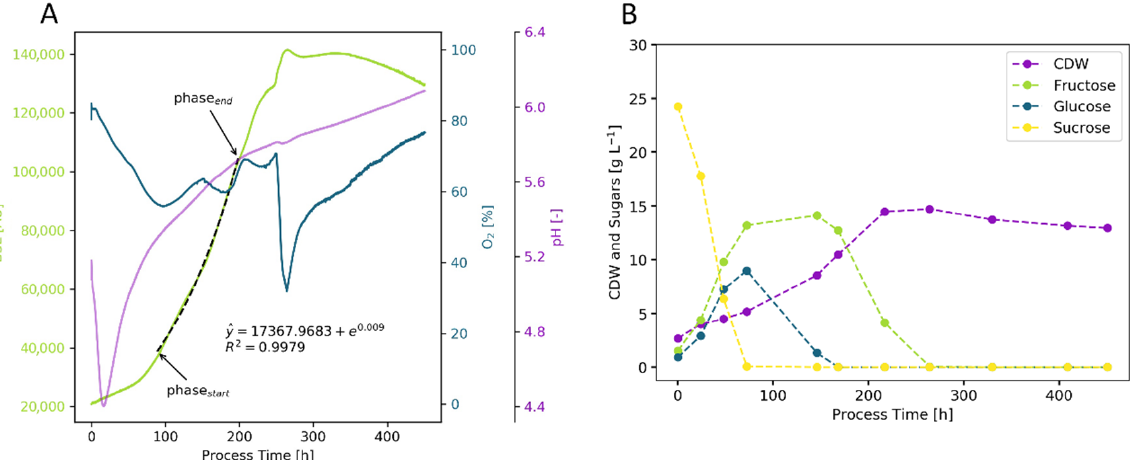
Figure 5. Cultivation of V. vinifera in 500 mL unbaffled shake flasks with 100 mL working volume, 120 rpm shaking rate and 50 mm shaking amplitude. For the algorithm-based determination of the growth rate, the BSL signal was used ( A , light green line, µ BSL, auto. = 0.0090 h − 1 ). Changes in carbon source uptake ( B , sucrose, glucose, and fructose measurements) are visible as drops in the dissolved oxygen signal ( A , blue line). The uptake of inorganic ions (data not shown) is visible at the pH signal (purple line), primarily the turning point after 16 h.